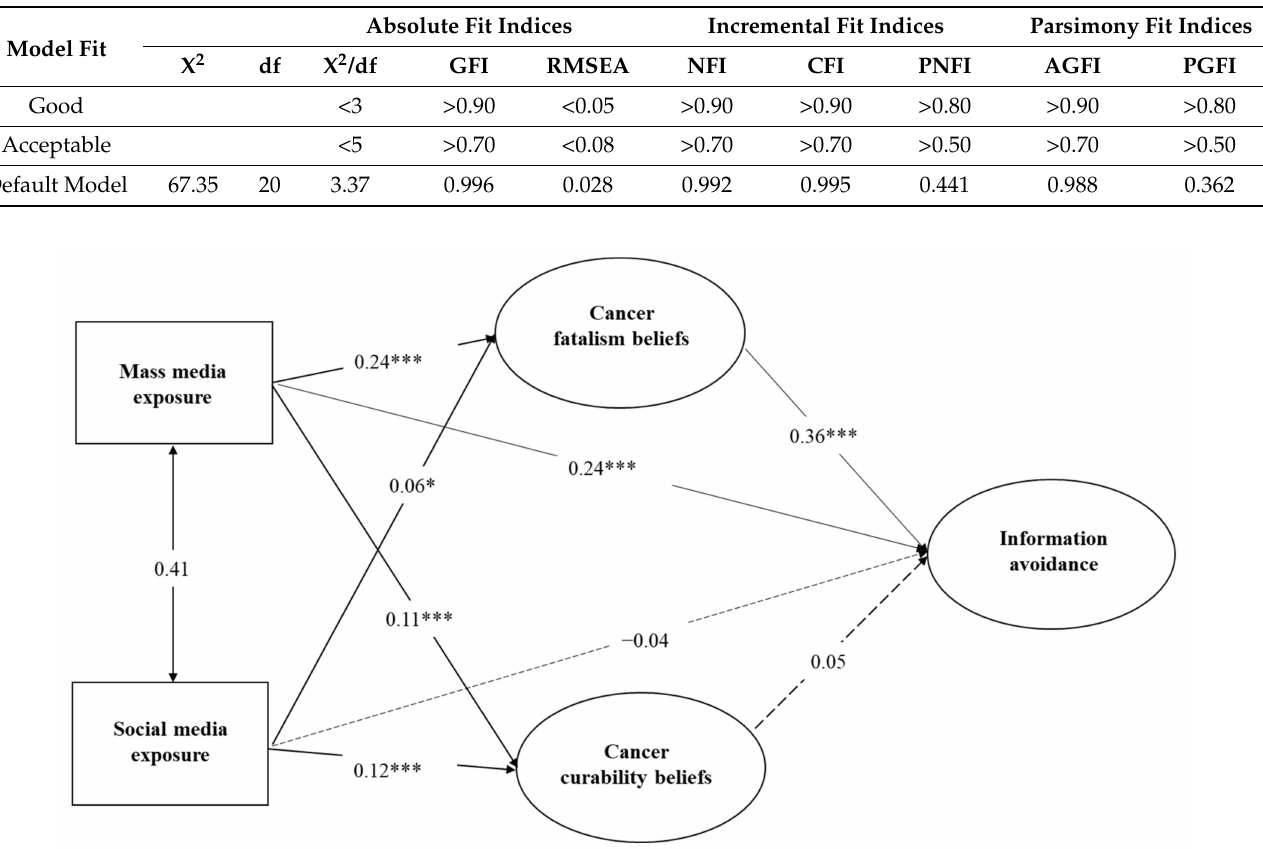
Table 4. Fit indices for Model 1.